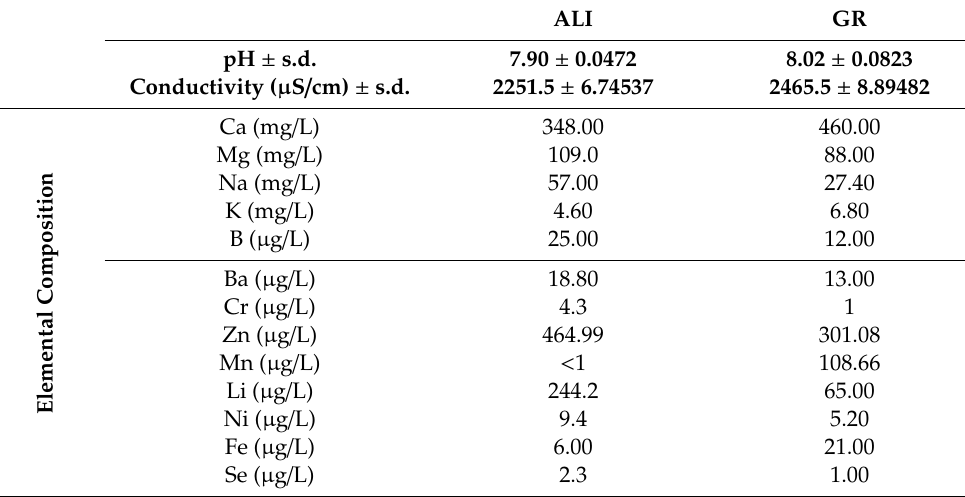
Table 2. Medicinal water characteristics and elemental composition determined by means of ICP-OES and ICP-MS (modified from [63]).